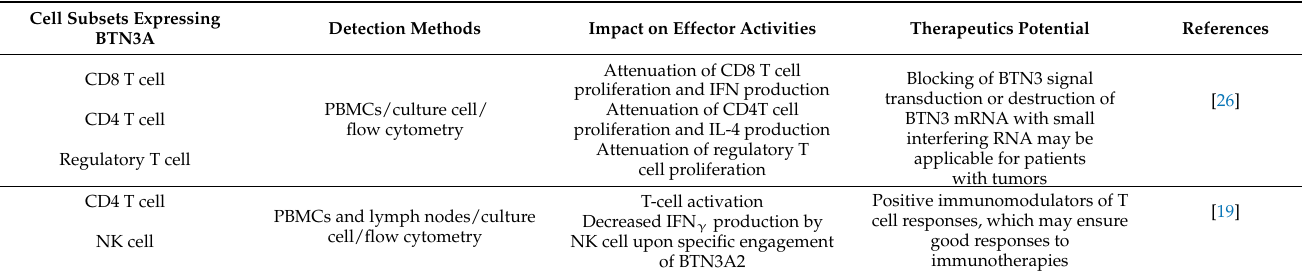
Table 2. Therapeutics potential of BTN3A molecules in